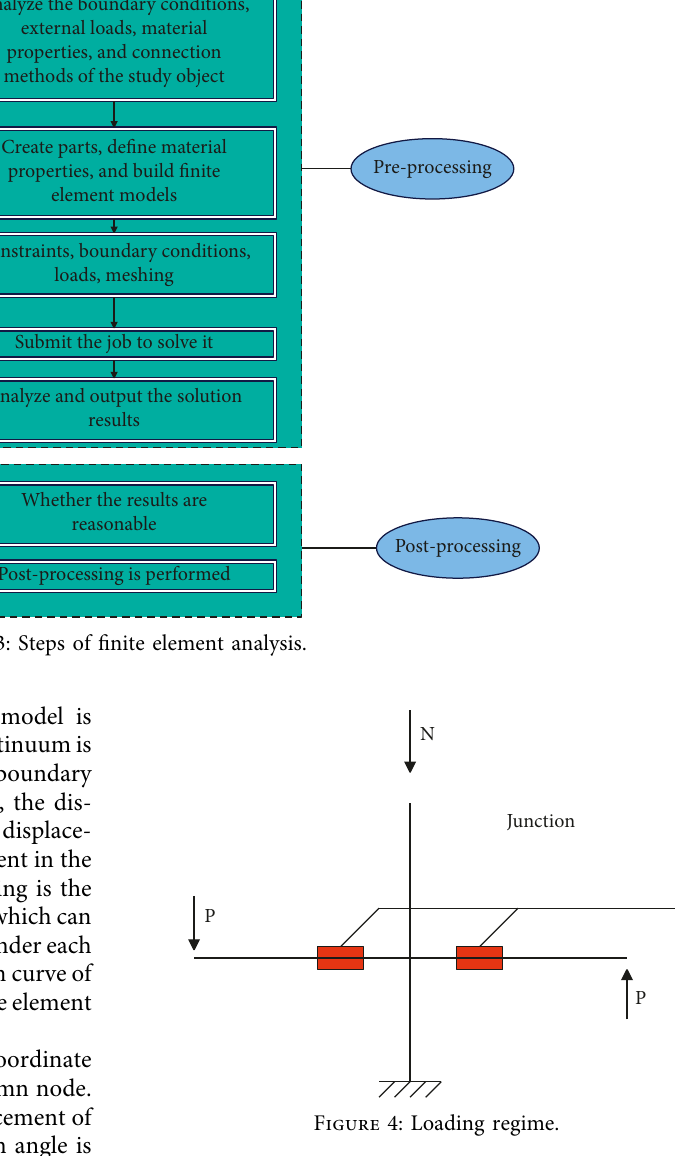
Figure 4: Loading